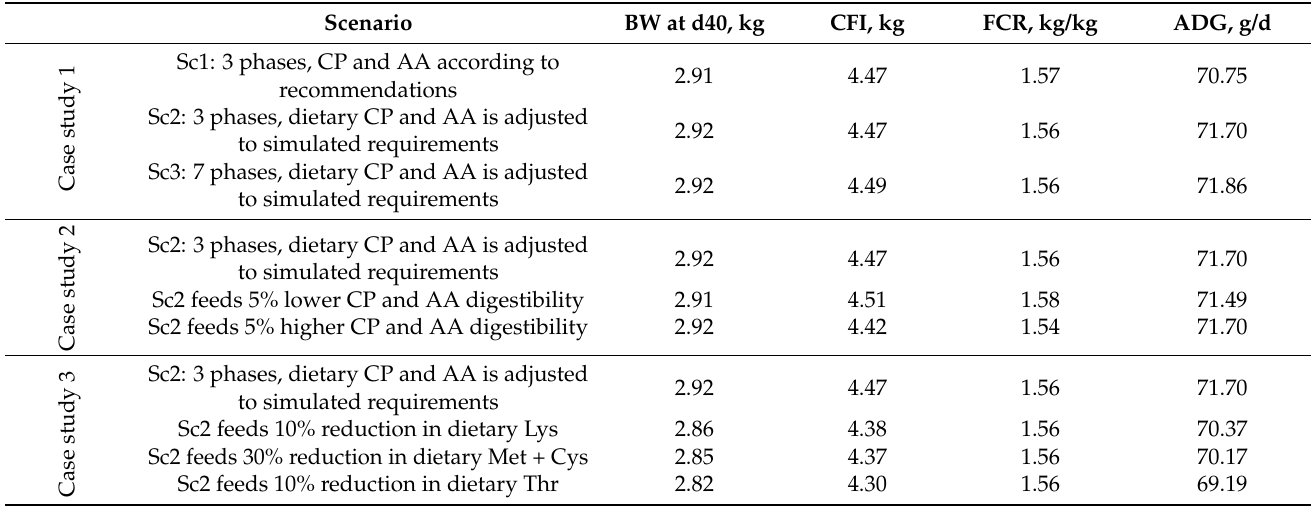
Table 2. Simulated performance in the case studies run with different scenarios.